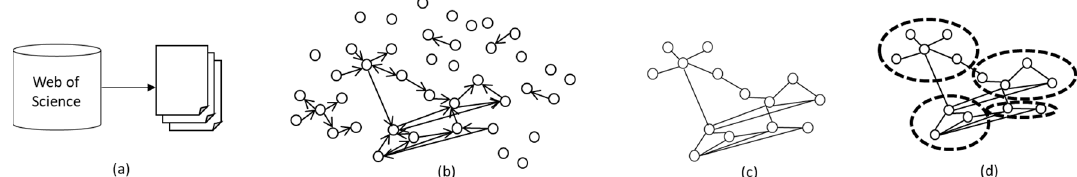
Figure 1. Data collection and methodology described in this article. ( a ) Data retrieval; ( b ) A citation network is created based on the references of the articles; ( c ) The largest connected component is extracted; ( d ) Clusters are obtained from the network.